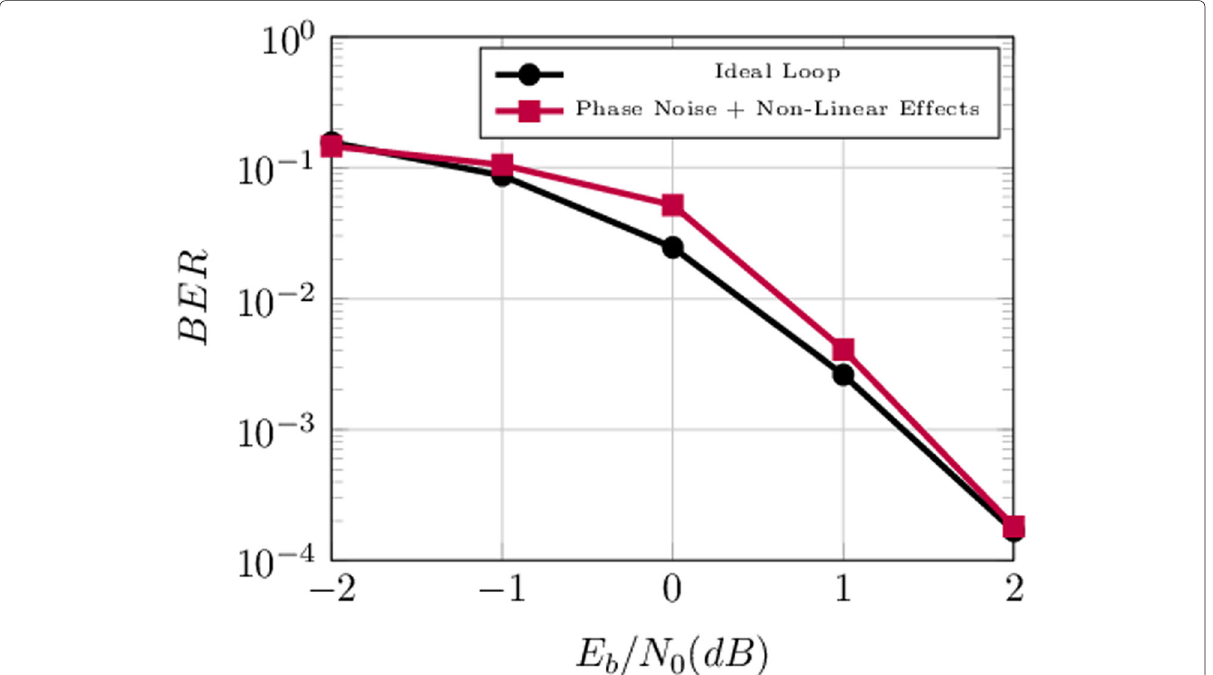
Fig. 15 Performance of our recovery loop under non-linearity and phase noise. MP-VCO’s model includes the flicker noise and thermal and shot noise. The mixer model includes bias and